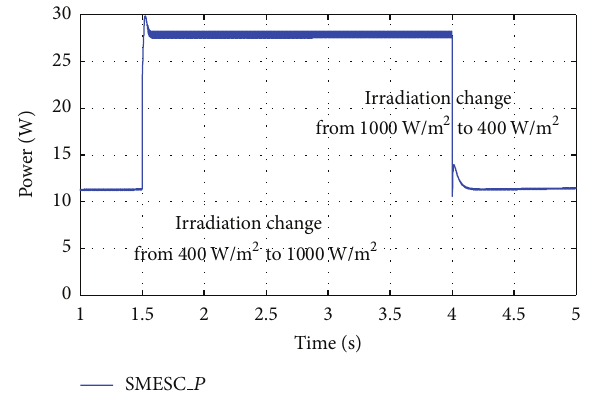
Figure 12: Simulation results for SMESC performance given step change in irradiance from 400 W/m 2 to 1000W/m 2 followed by step change from 1000 W/m 2 to 400W/m 2 .